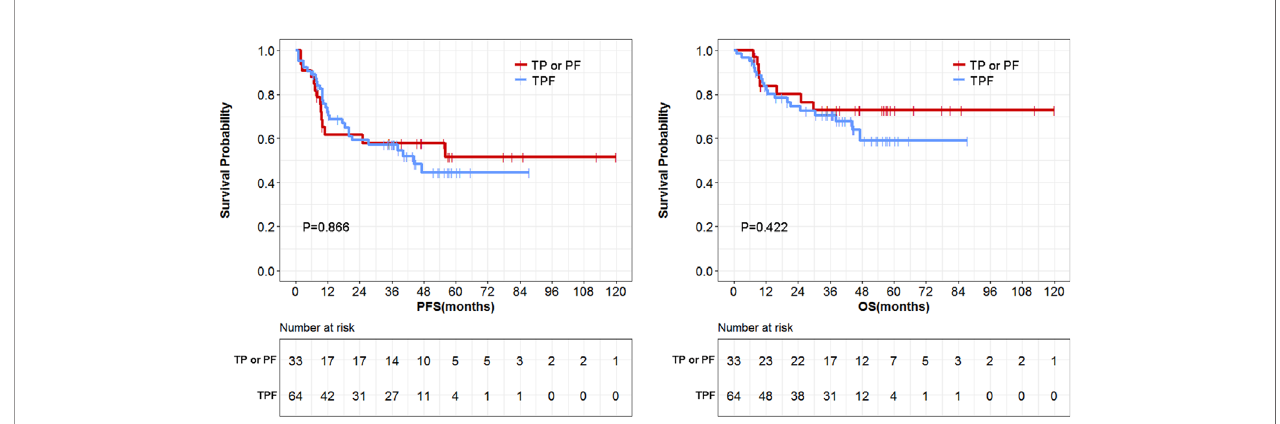
FIGURE 7 | Comparison of survival data between triplet TPF group and doublet TP or PF group. PF, platinum plus fl uorouracil; TP, docetaxel plus platinum; TPF, docetaxel, platinum and fl uorouracil.